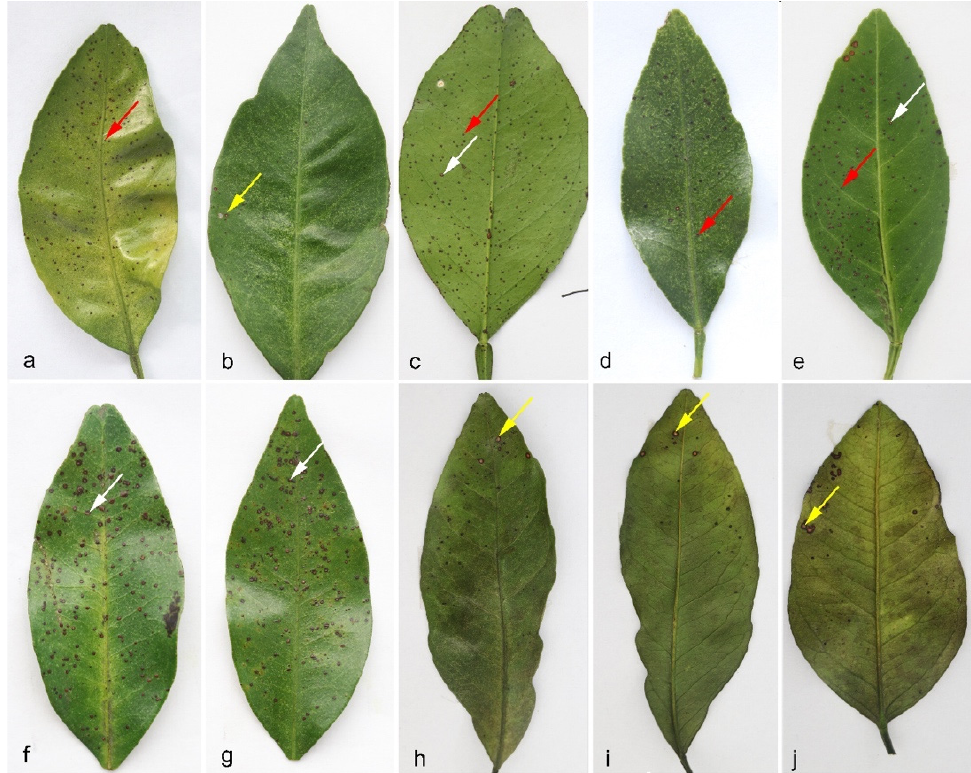
Figure 1. Symptoms of citrus leaf spots from which the Phyllostitca isolates were obtained. ( a – c ) C. sinensis , ( d – g ) C. reticulata , ( h – j ) C. unishiu . Red arrow, spot raised and hard, similar but bigger than melanose; white arrow, flat spot, with dark brown margin, gray-white and slightly sunken center; yellow arrow, spots with margin significantly raised, dark brown, and with gray-white, sunken center, similar to “hard spot” of black